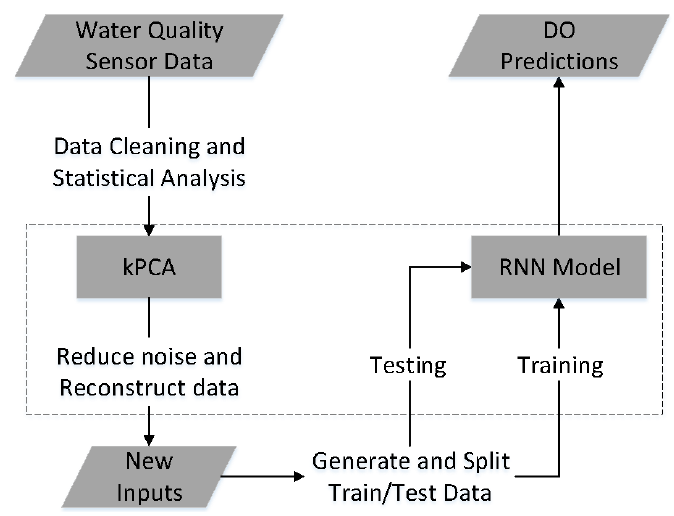
Figure 6. Workflow for predicting DO by applying the kPCA-RNN model. The dotted box highlights the key components of this proposed workflow.